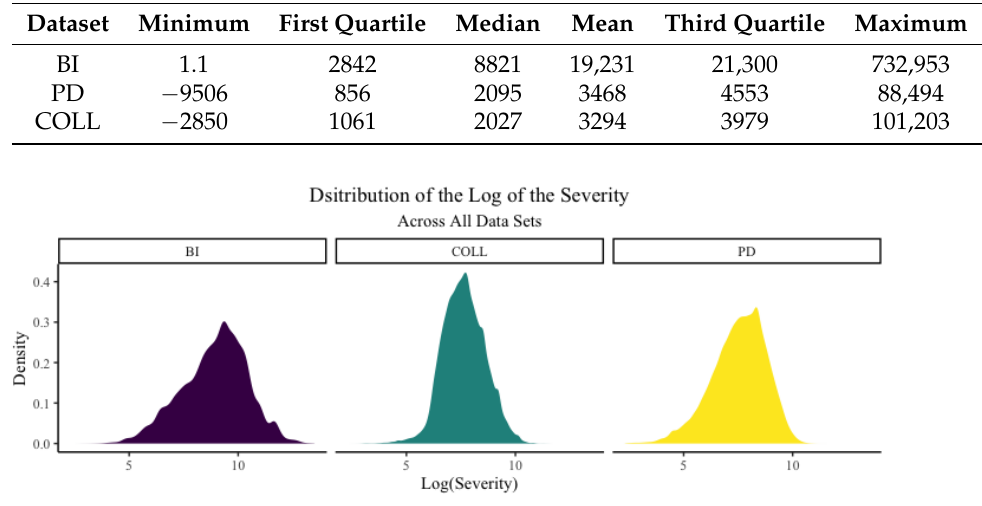
Figure 1. Distribution of the log of the severity for all